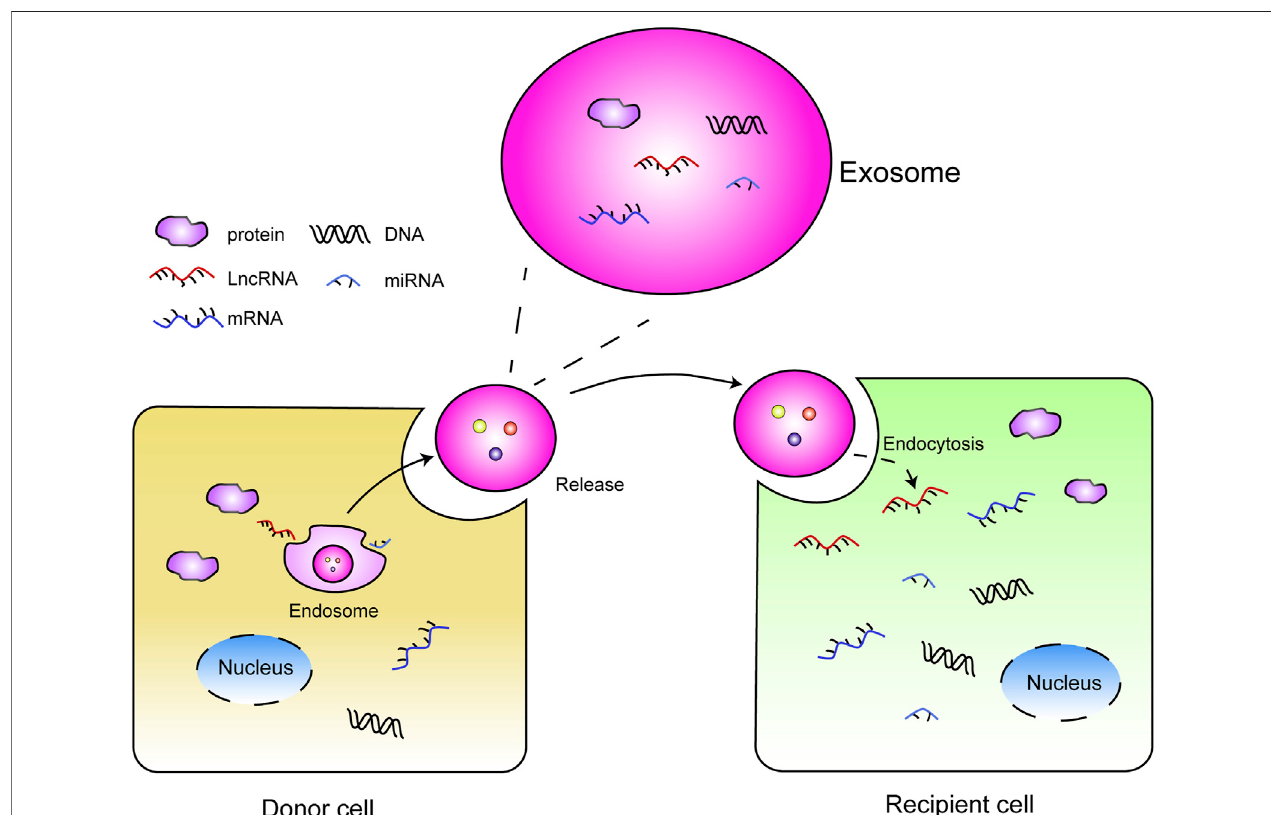
FIGURE1| Intercellularcommunication:donorcellsreleasetheexosomeswithcontents(DNAs,RNAs,protein)thatarereceivedbyrecipientcells via endocytosis, and the cargoes contained in exosome exert function in recipient cells.